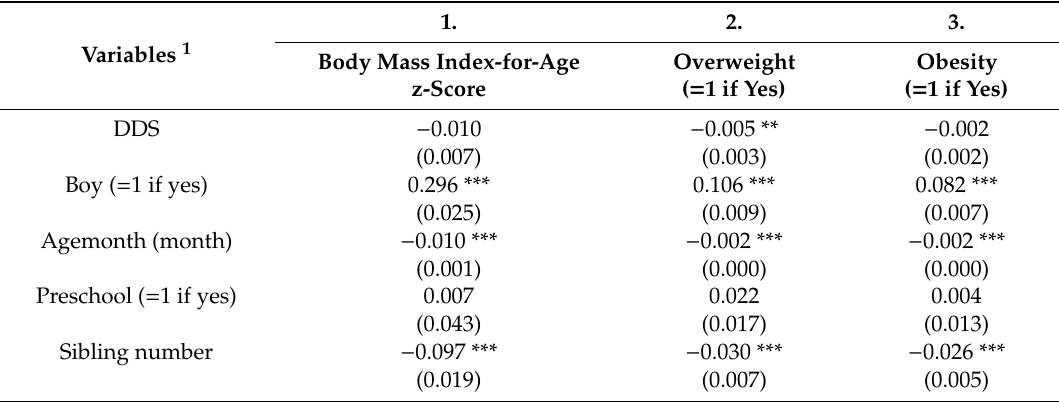
Table 4. Multivariate analysis of the correlation between DDS and nutrition outcomes for the overall